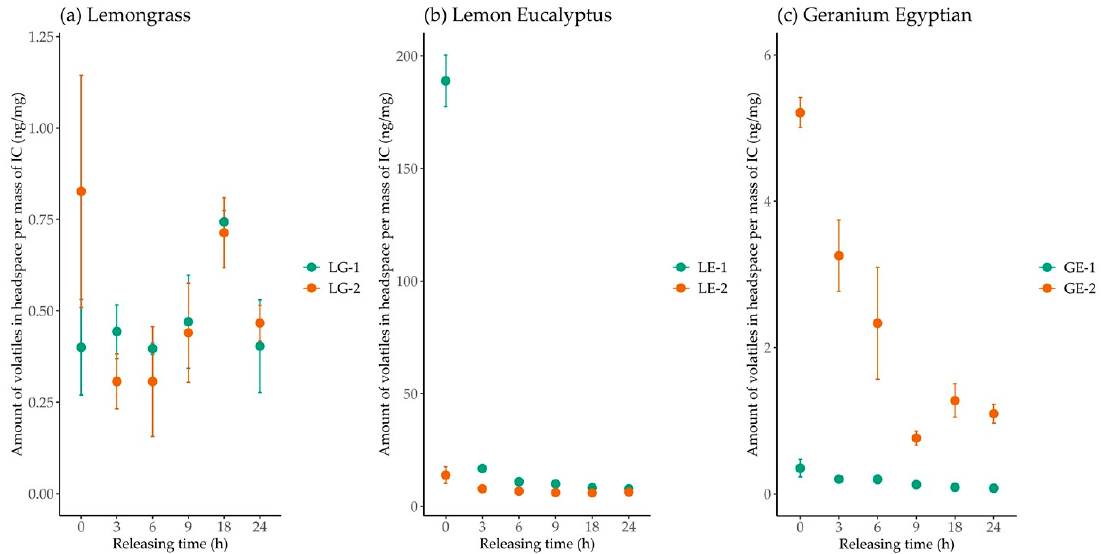
Figure 3. Essential oil (EO) volatiles from ( a ) lemongrass: β -cyclodextrin, ( b ) lemon eucalyptus: β -cyclodextrin, and ( c ) geranium Egyptian: β -cyclodextrin inclusion complexes released over time. Volatiles measured by SPME/GC-MS (N = 3). Quantification was done using liquid standard curves of corresponding EO in hexanes. The results compare the two inclusion complex preparation methods for each guest EO.